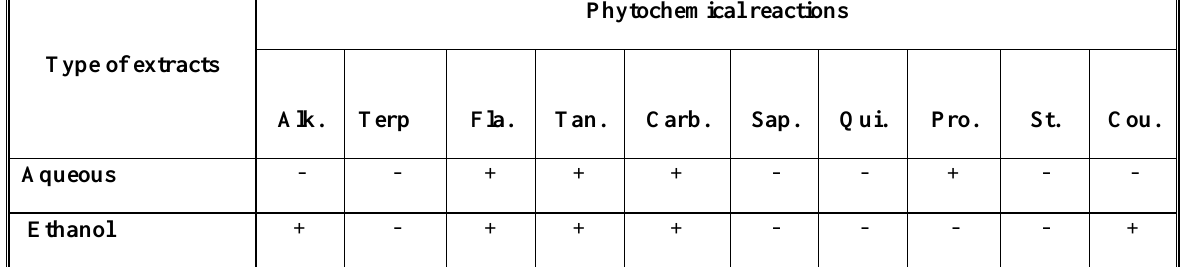
Table 3. Phytochemical screening test of both Ginkgo biloba extracts .